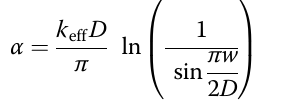
ffiffiffiffiffiffiffiffiffiffiffiffiffiffiffiffiffi p μ = ε ε represents the wave impedance 0 eff 0